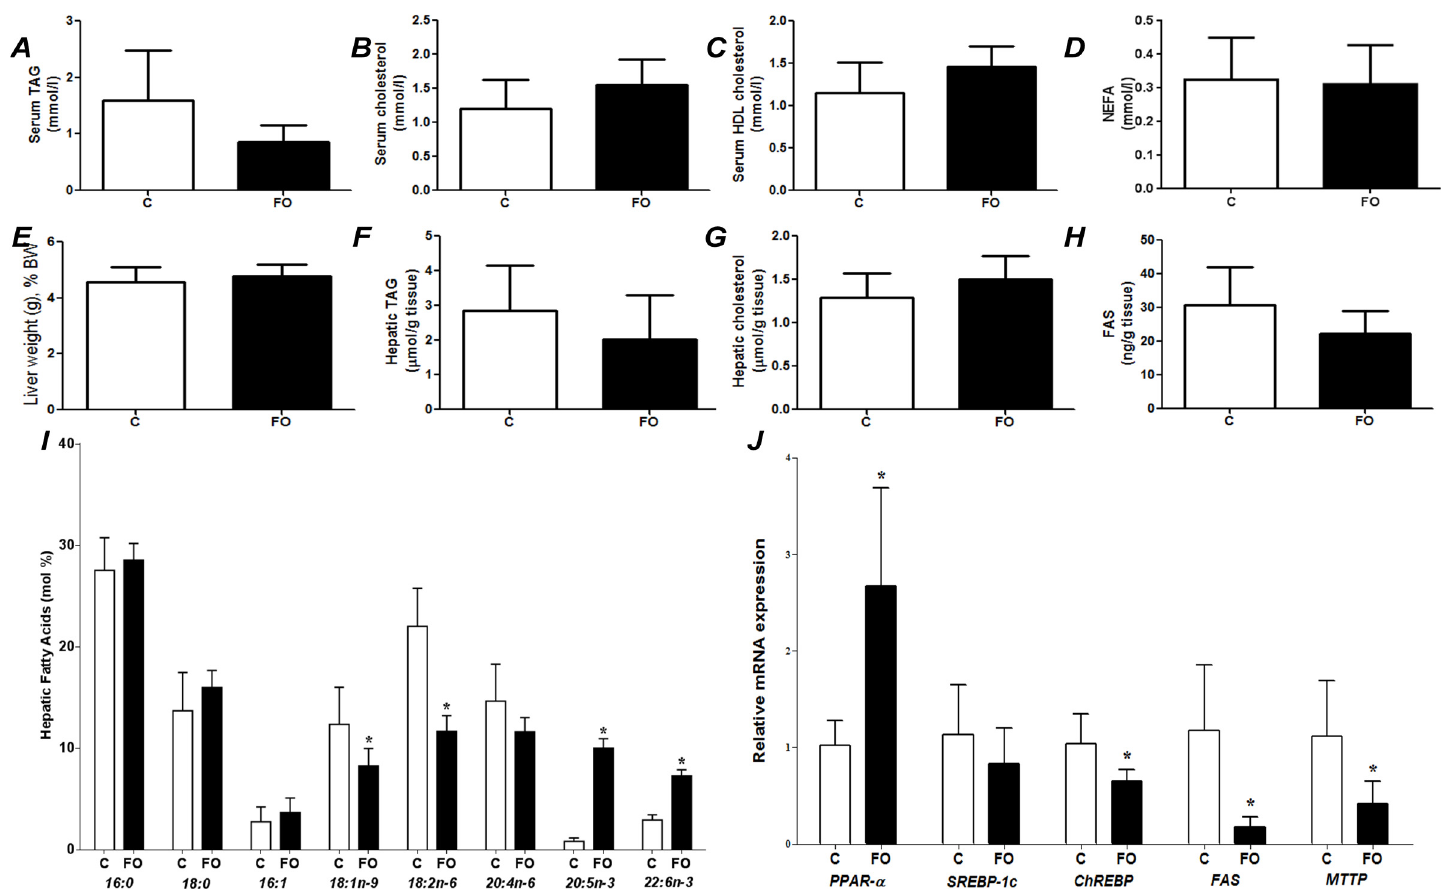
Figure 1. Fed state ( post-prandial ) parameters of rats fed a control (C) or fish oil (FO) diet for 7 days. ( A ) Serum triacylglycerol (TAG); ( B ) serum total cholesterol; ( C ) serum HDL cholesterol; ( D ) serum non-esterified fatty acids (NEFA); ( E ) liver weight as a percentage of body weight; ( F ) hepatic TAG; ( G ) hepatic total cholesterol; ( H ) hepatic content of fatty acid synthase; ( I ) hepatic fatty acid profile; ( J ) hepatic gene expression. PPAR- α —Peroxisome proliferator-activated receptor α ; SREBP-1c—sterol regulatory element binding protein-1c; ChREBP—carbohydrate responsive element binding protein; FAS—fatty acid synthase; MTTP—microsomal triglyceride transfer protein. * Indicates significantly different from control ( p <